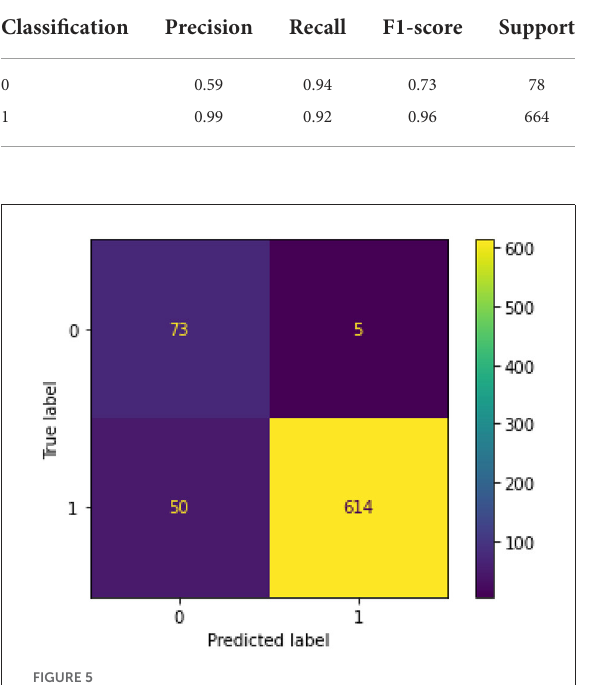
FIGURE5 Confusion matrix for final XGBoost